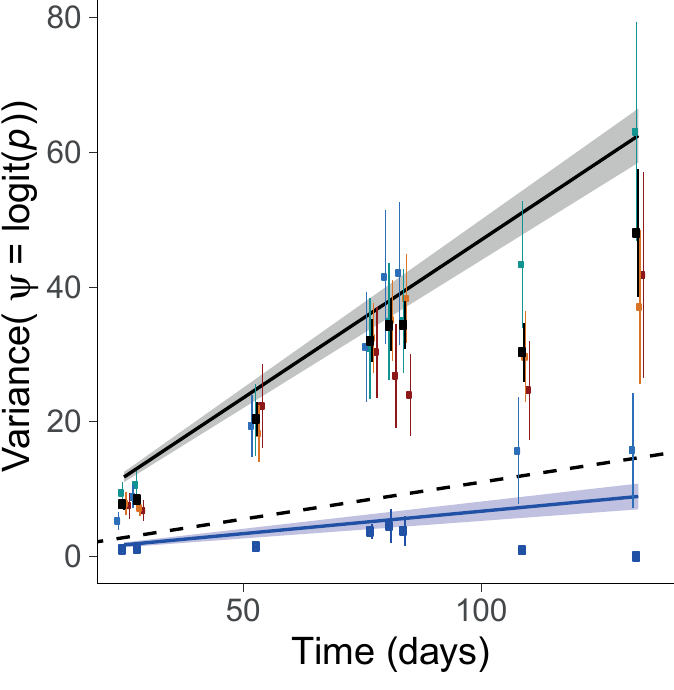
Fig 5. Frequency variance in constant versus fluctuating environments. Solid lines and ribbons represent the logistic regression estimation and standard errors (Eq (1)) in constant (blue) and stochastic (black) environments, while the dashed line is the prediction from the univariate selection reaction norm (Eq (2)). Dots and error bars are the mean and bootstrapped standard deviation of the realized logit frequencies estimated as random factors in the state-space model. Variance was assume to be the same within all constant treatments (blue) and all fluctuating treatments (black), and bootstraps were performed after subtracting the mean frequency. Bootstrapped variance measured in each autocorrelation treatment is also represented (-0.5 blue, 0 green, 0.5 orange, 0.9 red).